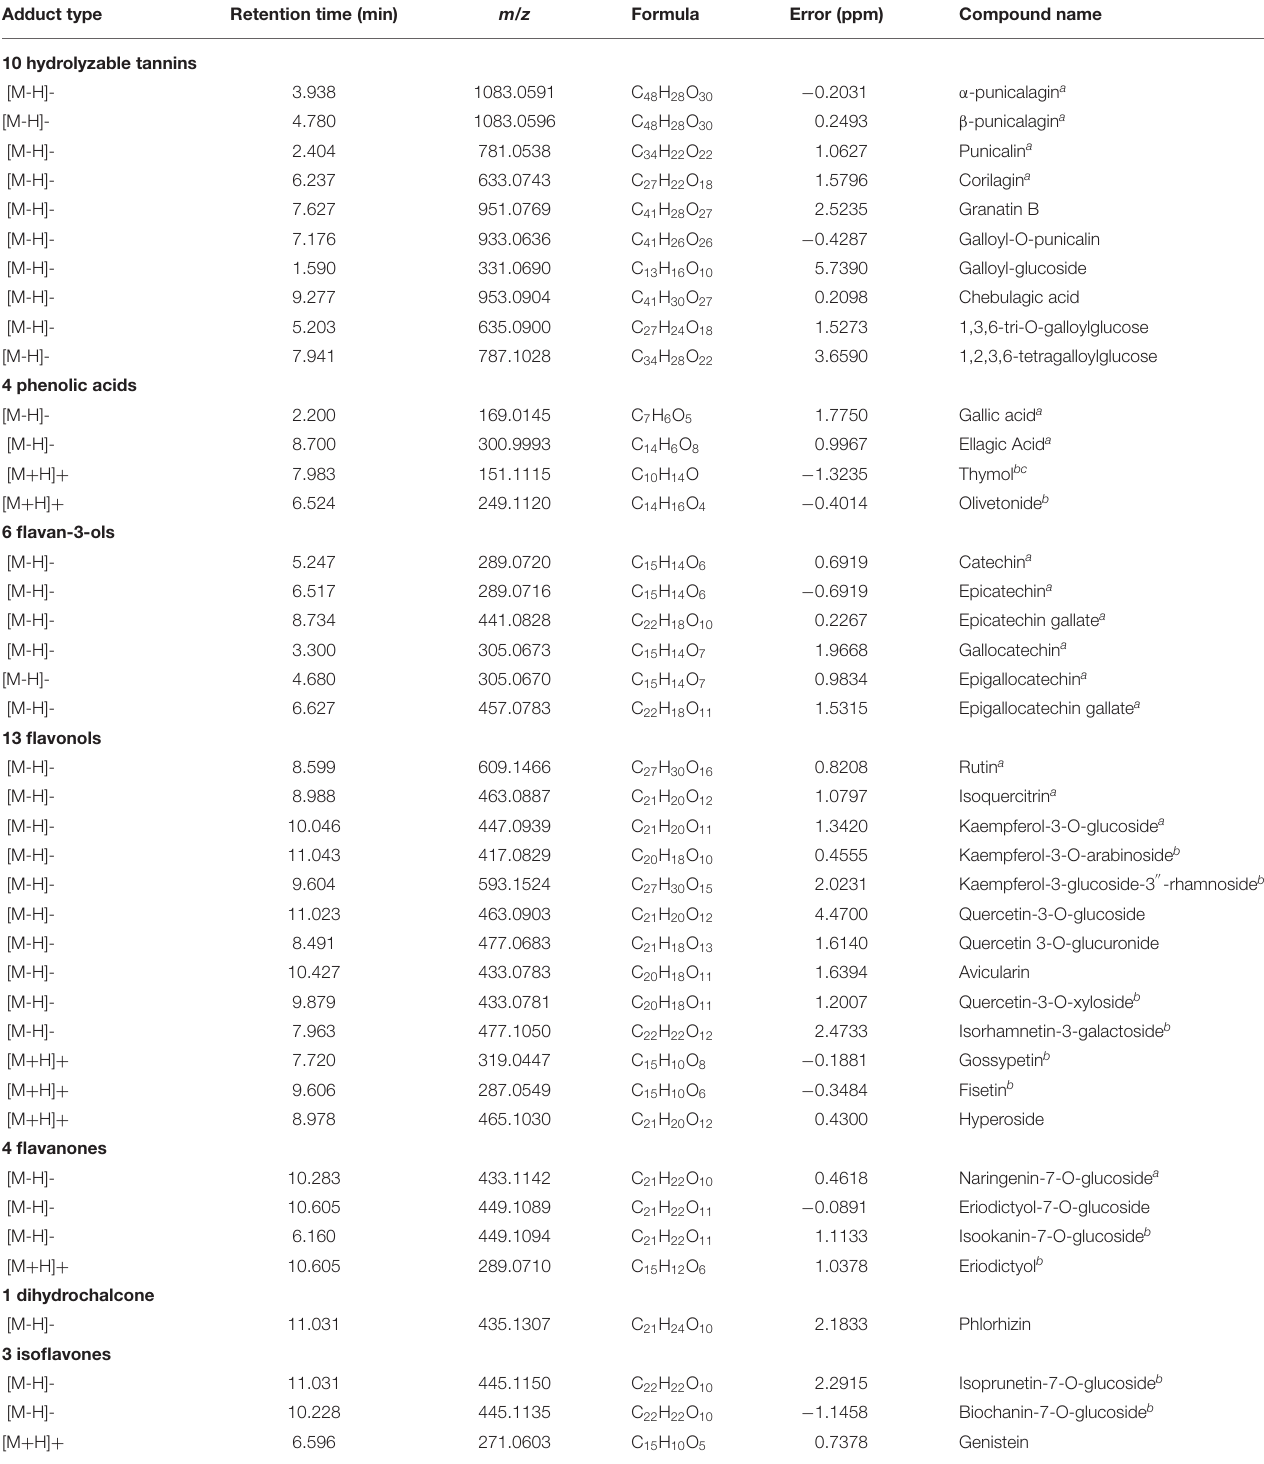
TABLE 1 | Annotation and identification of phenolic compounds by UHPLC-QTOF-MS. Adduct